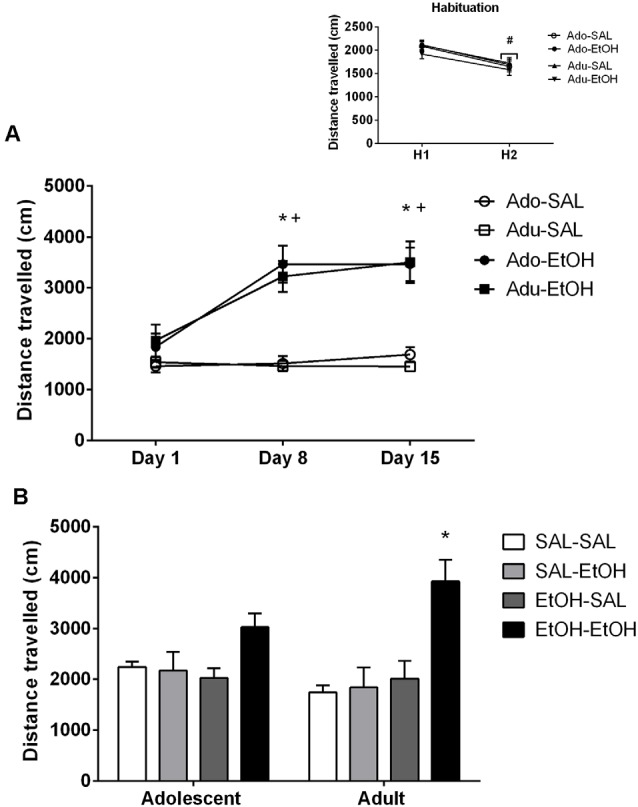
Locomotor activity of adolescent and adult mice. (A) Adolescent (Ado) and adult (Adu) mice were pretreated with saline (SAL) or ethanol (EtOH) during 15 consecutive days and the locomotor activity was assessed on Days 1, 8 and 15. *Denotes significant differences in locomotor activity from Day 1; +denotes significant differences in locomotor activity of ethanol-treated mice compared to saline-treated mice. The smaller figure shows the locomotion of mice injected with saline during two consecutive days (habituation days), #locomotion of each group on the second day of habituation (H2) was lower than on the first day they were exposed to the open-field (habituation day: H1). (B) Locomotor activity assessed on Day 21 in mice challenged with saline (-SAL) or ethanol (-EtOH) 5 days after pretreatment with saline (SAL-) or ethanol (EtOH-). *Denotes greater locomotor activity compared to all the other groups within the same age group. The values are expressed as mean ± SEM.